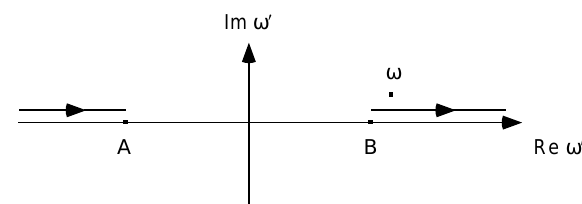
FIG. 7. Complex plane v 0 and the integration path for Eq. (A2). The points A and B correspond to the cutoff fre- quency 2 (cid:99) m (cid:110) (cid:44) (cid:109) (cid:121) (cid:98) (cid:48) and (cid:99) m (cid:110) (cid:44) (cid:109) (cid:121) (cid:98) (cid:48) , respectively. The frequency v has an infinitesimally small positive imaginary